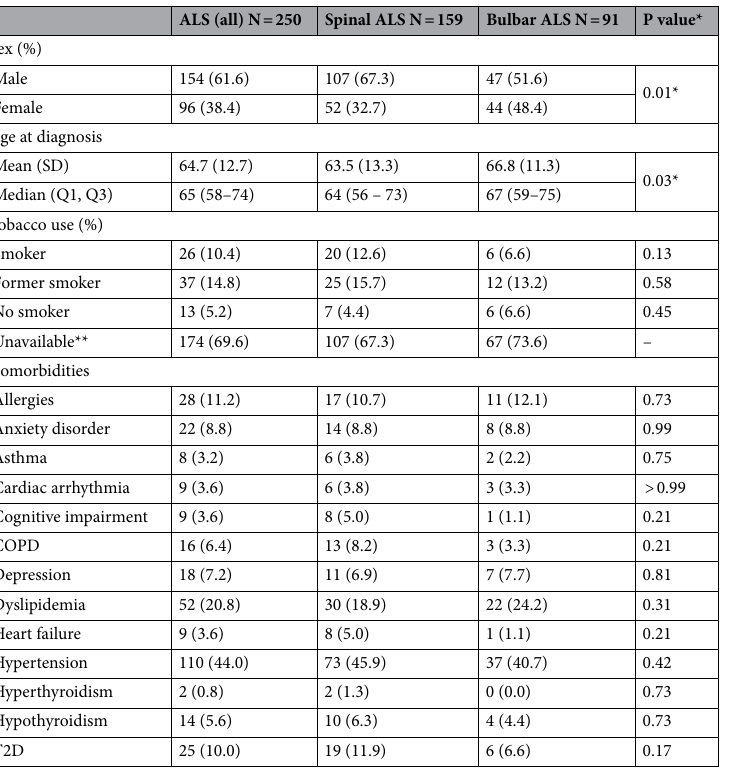
Table 1. Demographic and clinical characteristics at baseline. Baseline analyses were performed using a window of [− 3, + 1 months) around diagnosis date. *Statistically significant differences between spinal and bulbar ALS were calculated using Pearson’s chi-squared tests for categorical variables and t-statistic tests for numeric variables. **Unavailable information as not reported in patients’ EHRs. COPD = Chronic obstructive pulmonary disease, T2D = Type 2 diabetes.